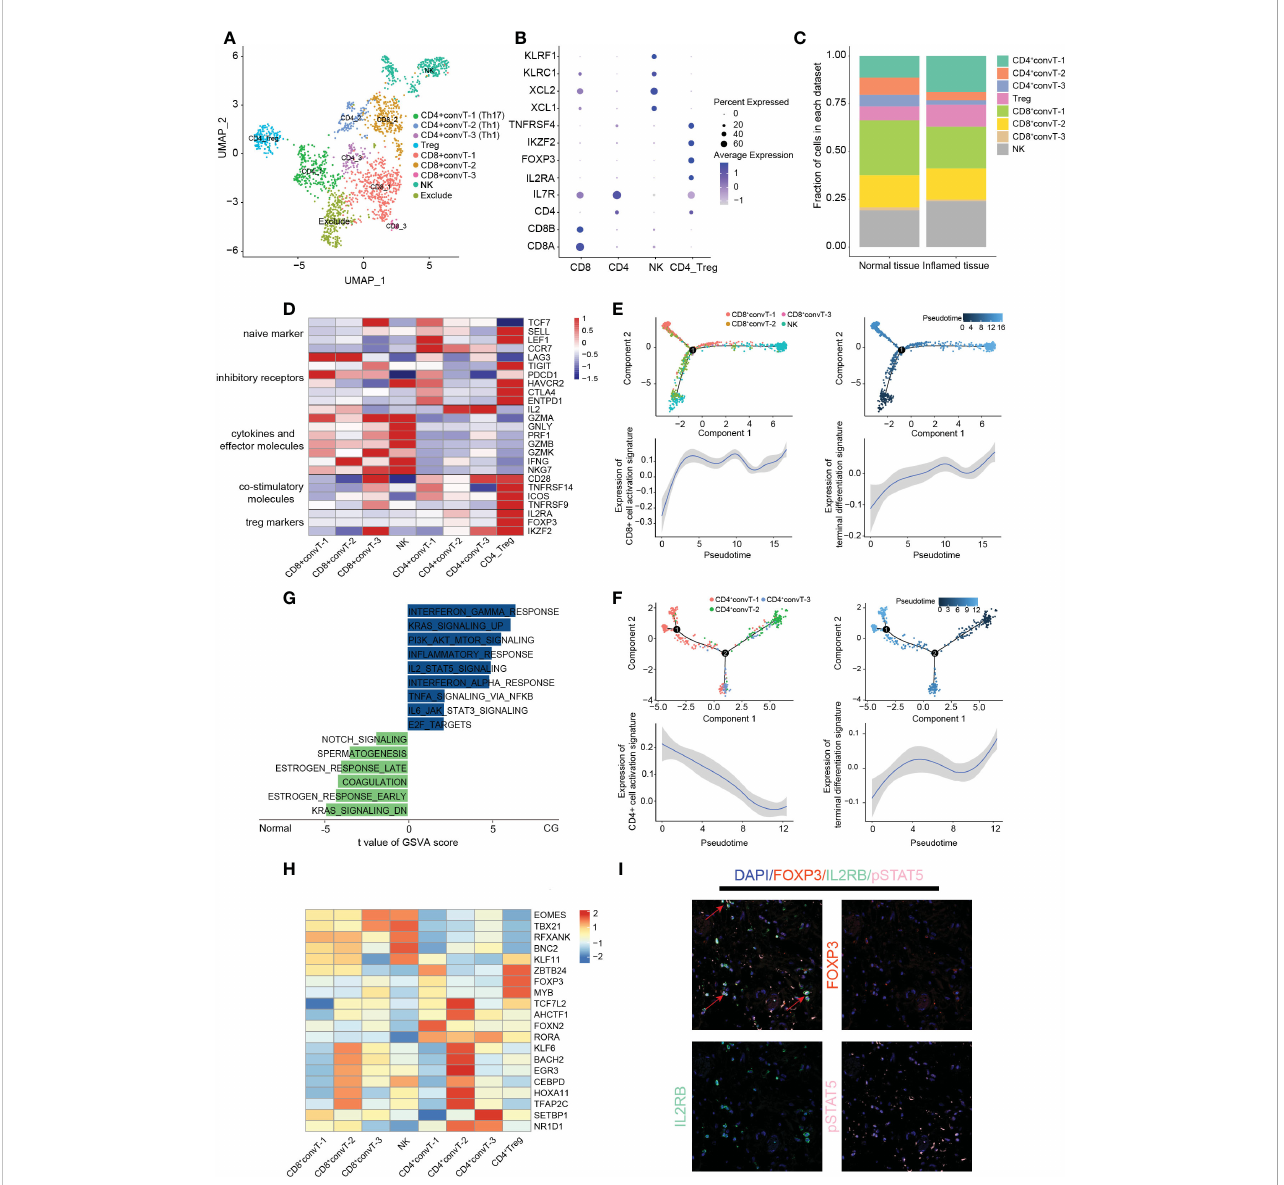
FIGURE 3 Classi fi cation and analysis of T cells in cystitis glandularis. (A) U-MAP plot showing different T cell subsets indicated by color. (B) Dot plot showing canonical genes used to distinguish different subsets of T cells. (C) The proportion of cells of different subsets of T cells in normal and CG tissues. The left panel indicates normal tissue and the right panel indicates in fl amed tissue. (D) Heat map showing functional gene sets of different T-cell subsets. (E, F) Monocle2 inferences of the pseudotime trajectory of T cells. Above: pseudotime trajectory of CD4+ T cells/CD8+ T cells of all samples annotated with different colors or color depth, respectively. Bottom: Trends of expression of activated and terminated gene sets in CD4+ T cells/CD8+ T cells along with pseudotime trajectory. The gene sets used can be seen in supplementary table S5. (G) GSVA enrichment analysis of NK cells in CG and normal tissues. The horizontal axis shows the enrichment score, the right side shows the CG enrichment function, and the left side shows the normal tissue enrichment function. This fi gure displays only part of the In fl ammation related pathway – see supplementary table S7 for all enrichment results. (H) Heat map showing the regulation of transcription factors within T cells. (I) Multiplex immuno fl uorescence showing the expression of the IL2RB- pSTAT5-FOXP3 activation pathway in Treg cells. The red arrow indicates the Treg cells activated by this activation